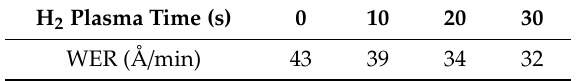
Table 2. Wet etch rate as a function of H 2 plasma exposure time in the three-step